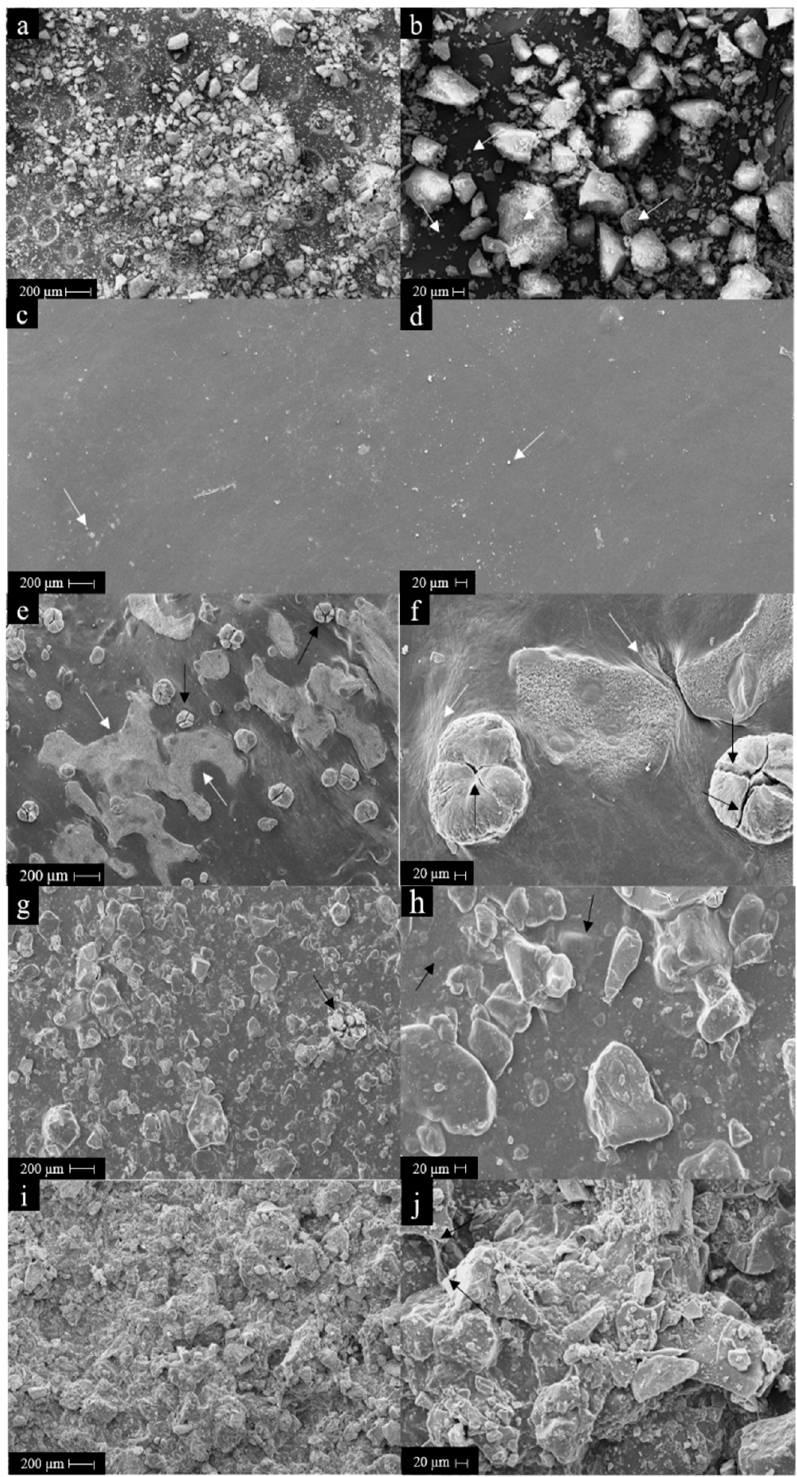
Figure 4. SEM of HA powder and membranes surface at different magnifications. ( a , b ) Aspect of the HA powder obtained in the synthesis process. Aspect of the surface of the different membrane formulations: ( c , d ) C 1 X 1 HA 0 ; ( e , f ) C 1 X 1 HA 0.4 ; ( g , h ) C 1 X 1 HA 2 ; ( i , j ) C 1 X 1 HA 10 . The black and white arrows highlight particular characteristics observed during the analysis of the